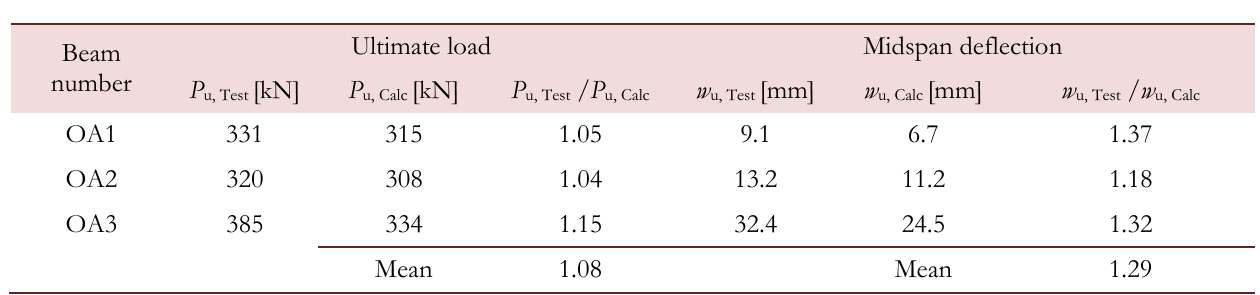
Table 5: Comparison of the numerical calculations and experiments – alternative 2.